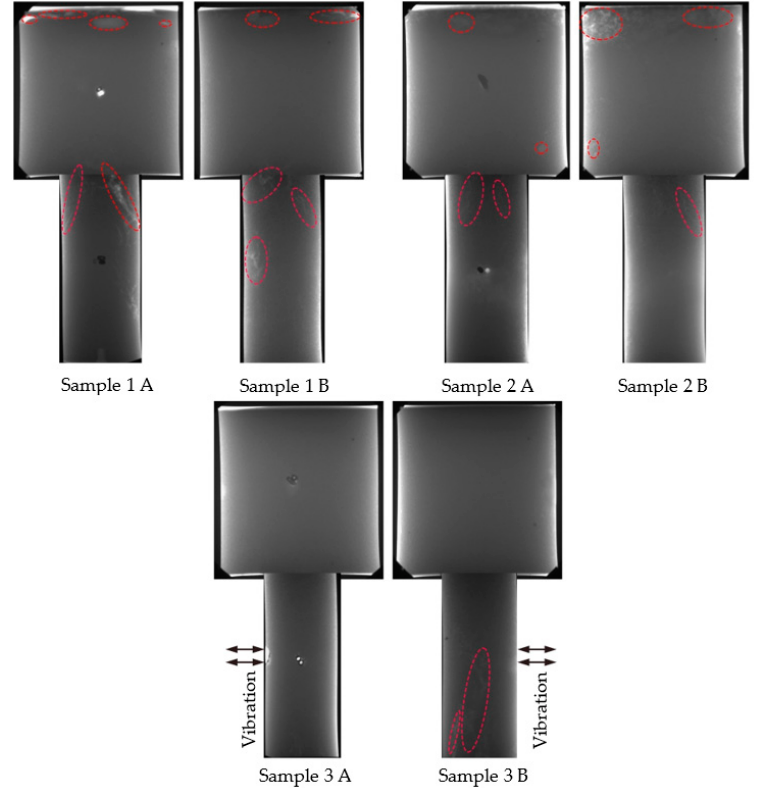
Figure 4. X-ray detection results of samples. Note: The red dashed ellipses indicate the shrinkage defects.